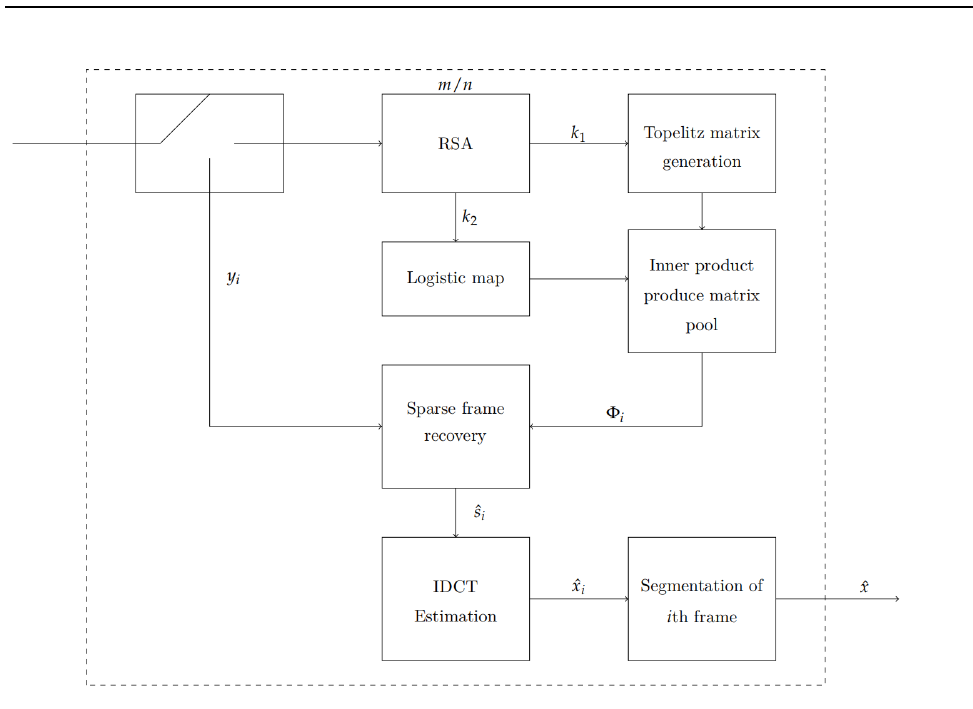
Figure 4. Receiver’s decryption and decompression process. Algorithm 4: Receiver’s decryption and decompression